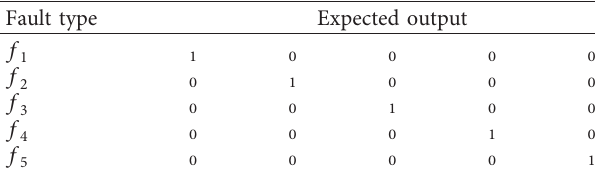
Figure 7: Variation trend of eight parameters under five different working conditions. (a) Air flow change trend. (b) Coolant temperature change trend. (c) Engine load change trend. (d) Engine speed change trend. (e) Exhaust camshaft position change trend. (f) Fuel supply advance angle change trend. (g) Intake camshaft position change trend. (h) Intake manifold pressure change trend. Table 3: Expected output of neural